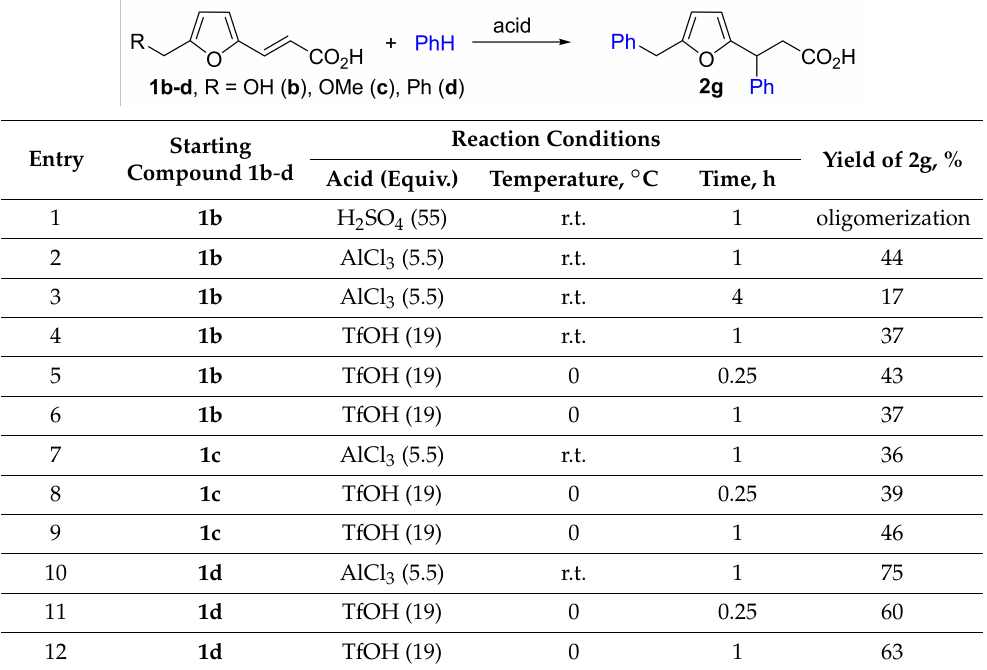
Table 2. Reaction of acids 1b – d with benzene under the action of Brønsted or Lewis acids leading to compound 2i .